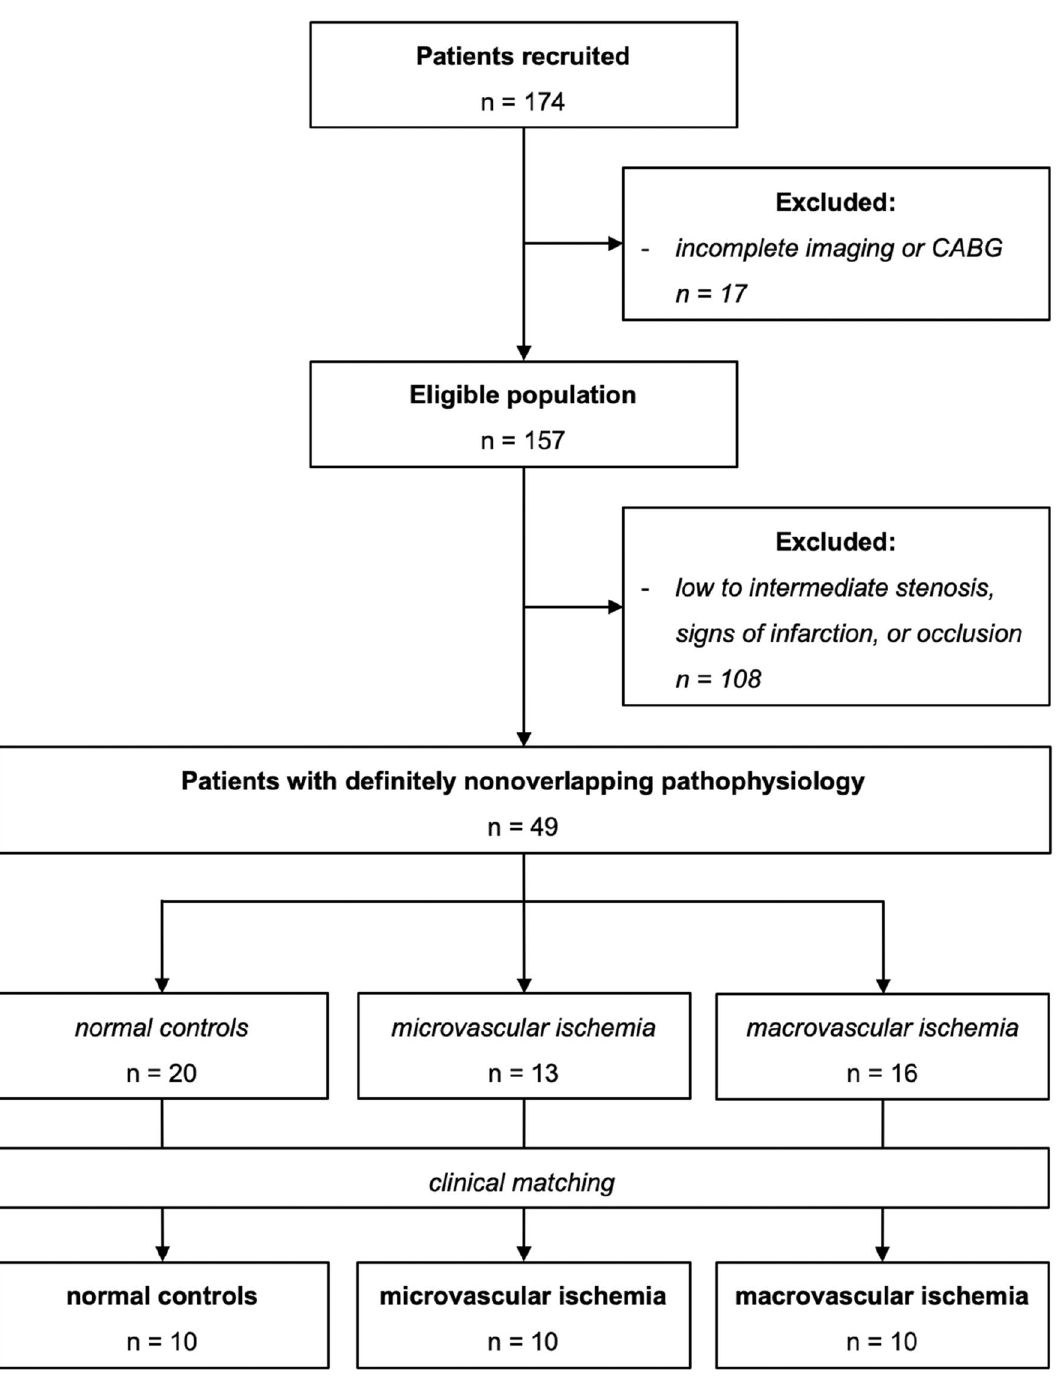
Figure 1. Flow chart of patient selection to assemble a rigorously defined cohort with nonoverlapping perfusion pathophysiology. Remaining eligible cases were selected by clinical matching, if